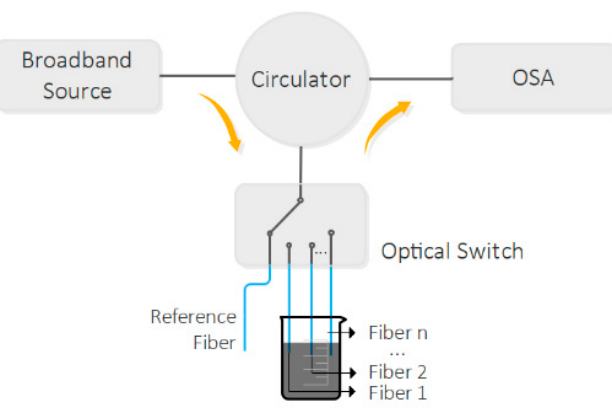
Figure 1. GO adsorption kinetics experimental setup.